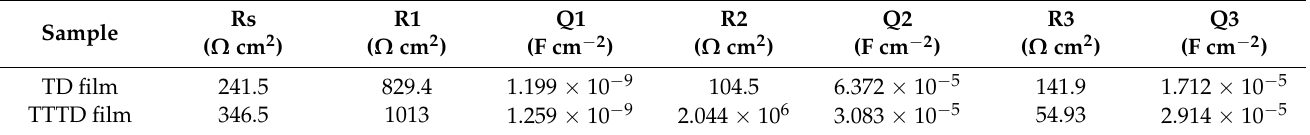
Figure 11. Fitted equivalent circuit diagram in weak acid solution: ( a ) TD film ( b ) TTTD film. Here, Rs is the solution resistance between the DLC film and the electrode, Q1 is the capacitance of the DLC film, R1 is the conduction resistance of the solution passing through the voids and defects of the DLC film, R2 is the conduction resistance of the passivation film voids and defects, Q2 is the capacitance of the passivation film, R3 is the polarization resistance between the film and the substrate, and Q3 is the electric double layer capacitance generated by the solution reaching the interface between the film and the substrate. Table 4. Electrochemical impedance fitting data of TD film and TTTD film in weak acid